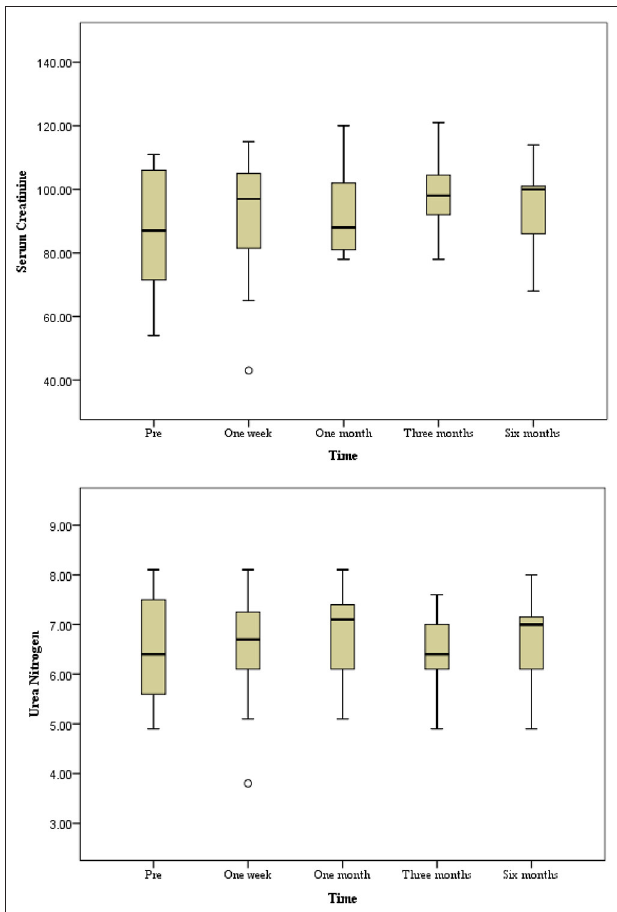
FIGURE 3 | The progression of renal function during a six-month follow-up period. No significant changes in serum creatinine and urea nitrogen level preintervention and postintervention during follow-up period ( P >